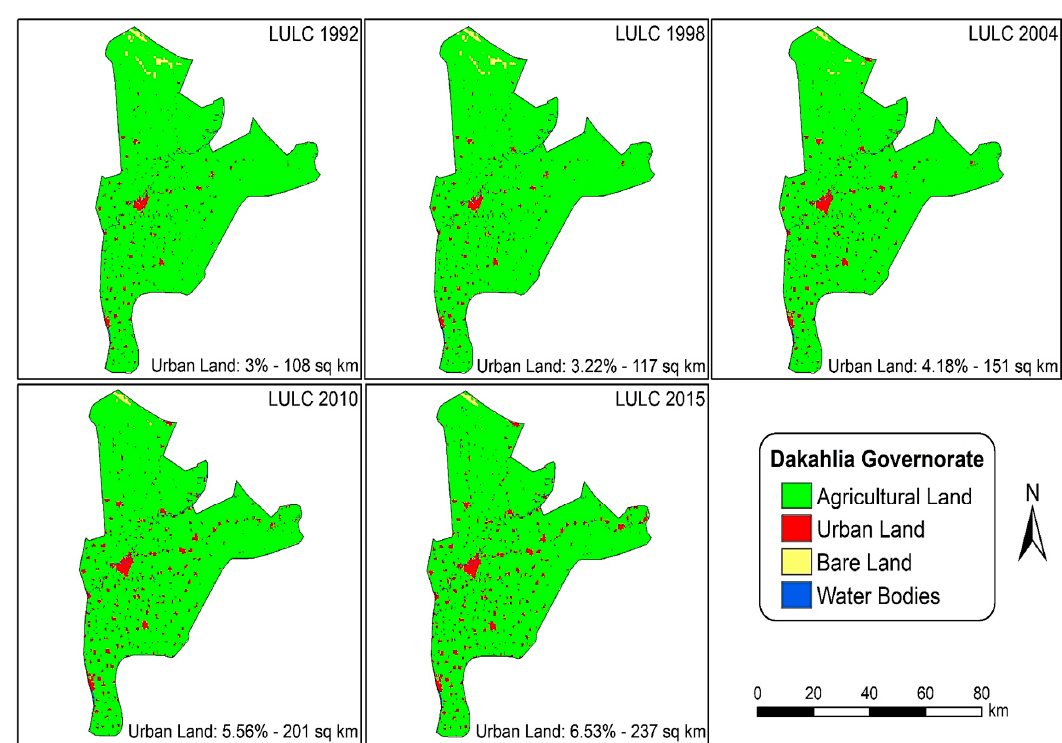
Figure A1. Urban expansion over Dakahlia governorate.